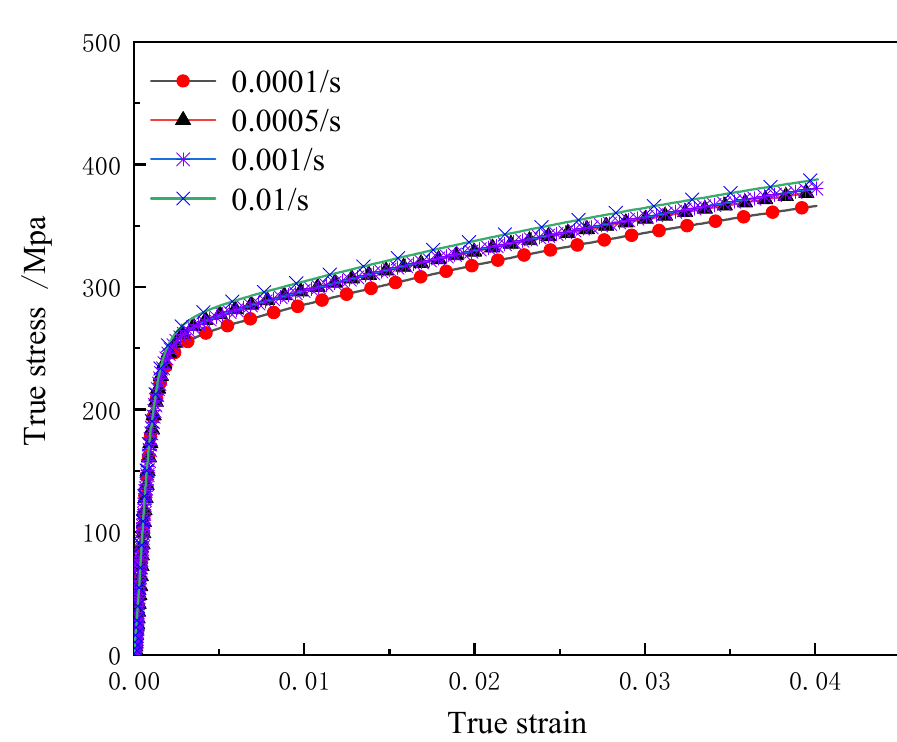
Figure 5. 304 stainless steel tubing true stress–true strain curve.